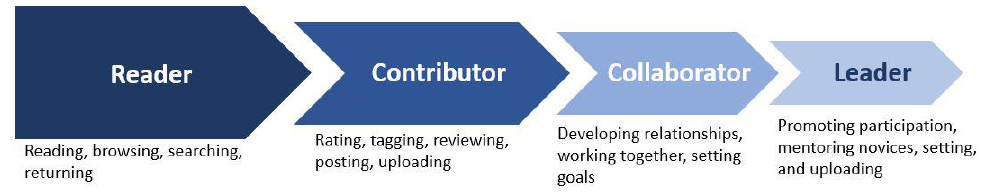
Figure 1. The “Reader-to-leader” framework adapted from Preece and Shneiderman [34], which illustrates the pattern of participant evolution in online social media communities. The sizes of the arrows illustrate the number of users. The number of users from reader to leader decreases in each category, meaning that the minority of users contribute the majority of contents.